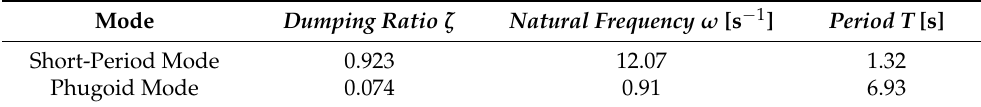
Table 8. Properties of short period and phugoid mode for